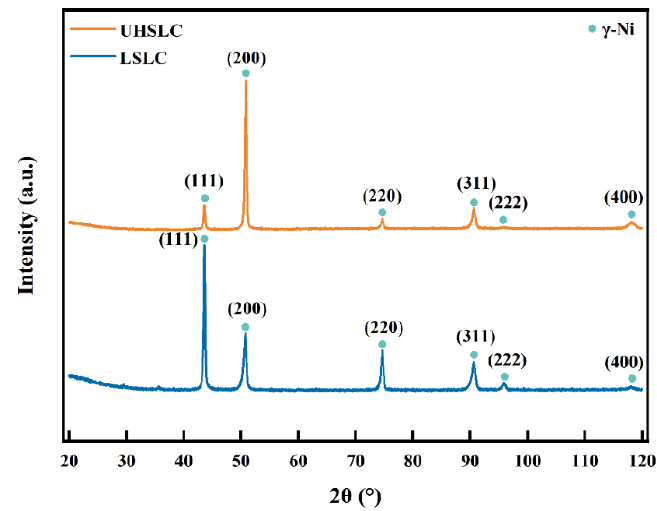
Figure 8. X-ray diffraction patterns of Inconel625 alloys coatings prepared by UHSLC and